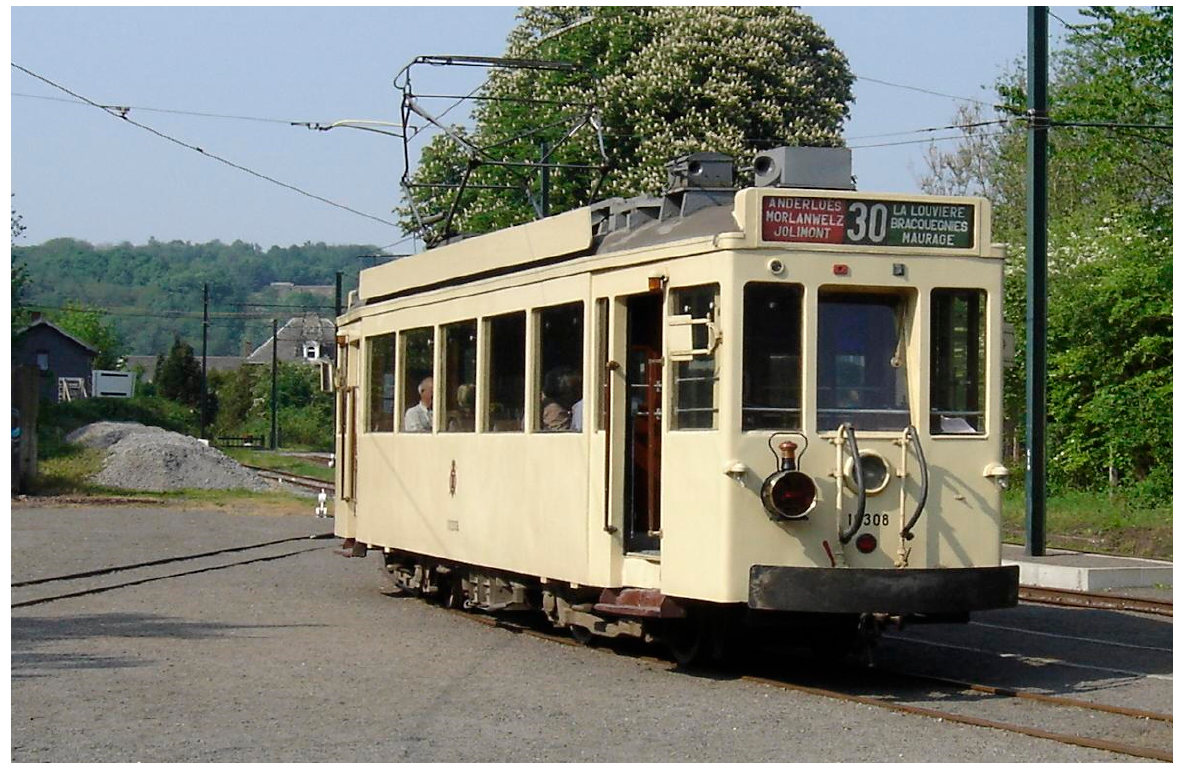
Figure 10. Train experience.